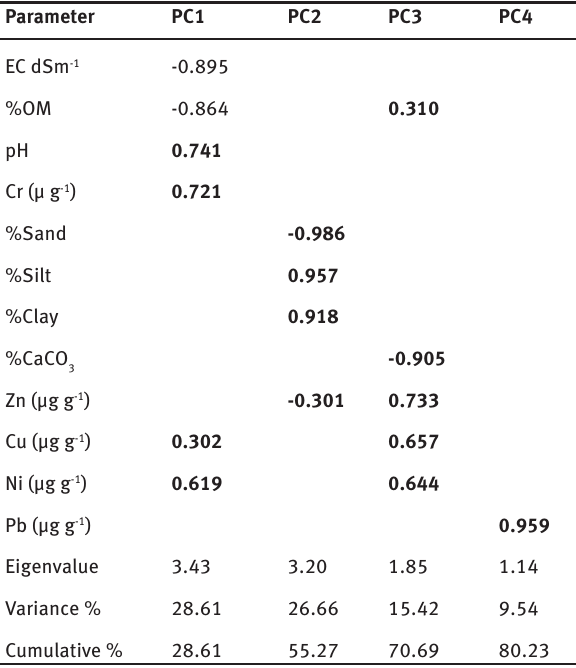
Table 9: Rotated principal component analysis (PCA) with varimax for various parameters in soil